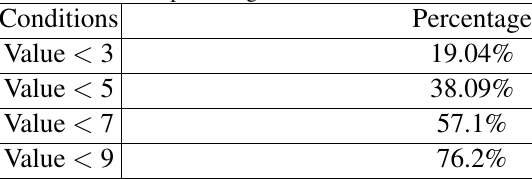
Table 5. The percentage of the data in the result